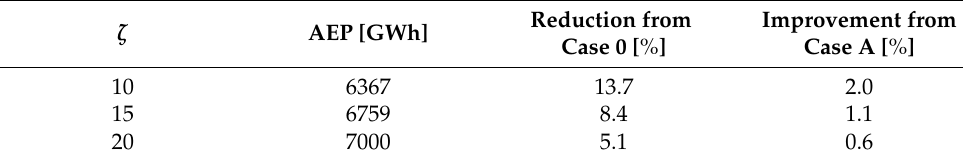
Table 5. AEP values for Case